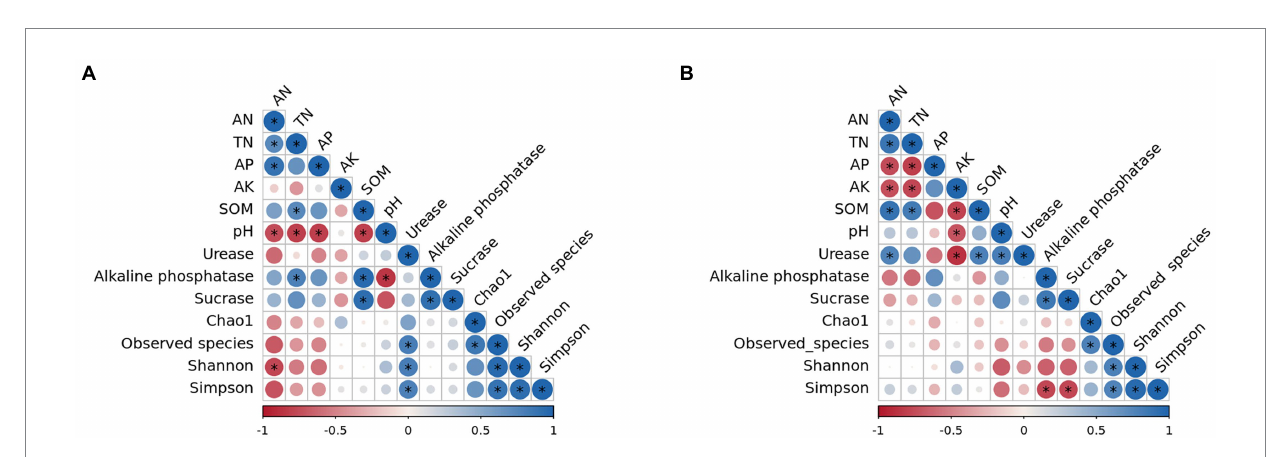
Figure 9. In surface soil (Figure 9A), RDA1 and RDA2 accounted for